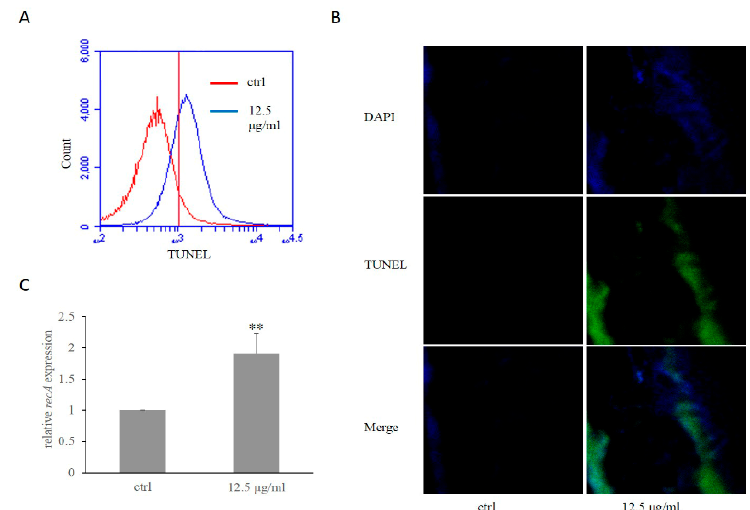
Figure 4. Detection of DNA damage and recA expression in H. pylori . DNA damage detected using TUNEL by flow cytometry ( A ) and confocal ( B ). ( C ) The expression of recA in H. pylori with/without daphnetin exposure. (** p < 0.001 vs. control). The expression of the study genes without daphnetin exposure was normalized as 1.